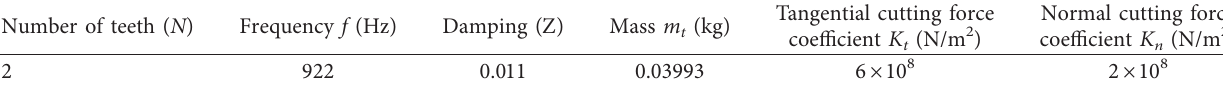
Table 2: Parameters for the milling process.